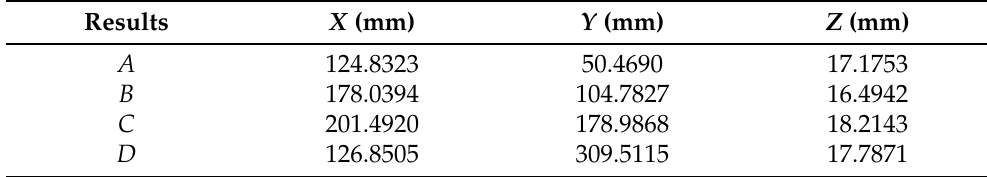
Table 5. Calculation results of space points of first experiment.